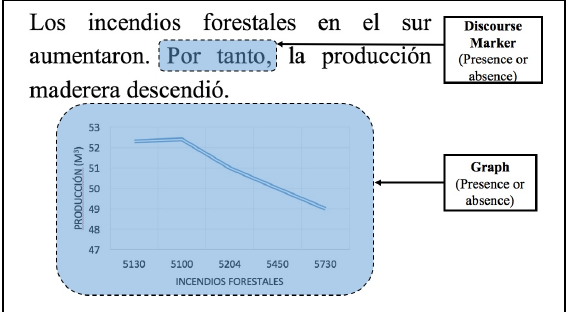
Figure 1. Illustration of the two factors DM and G and their possible